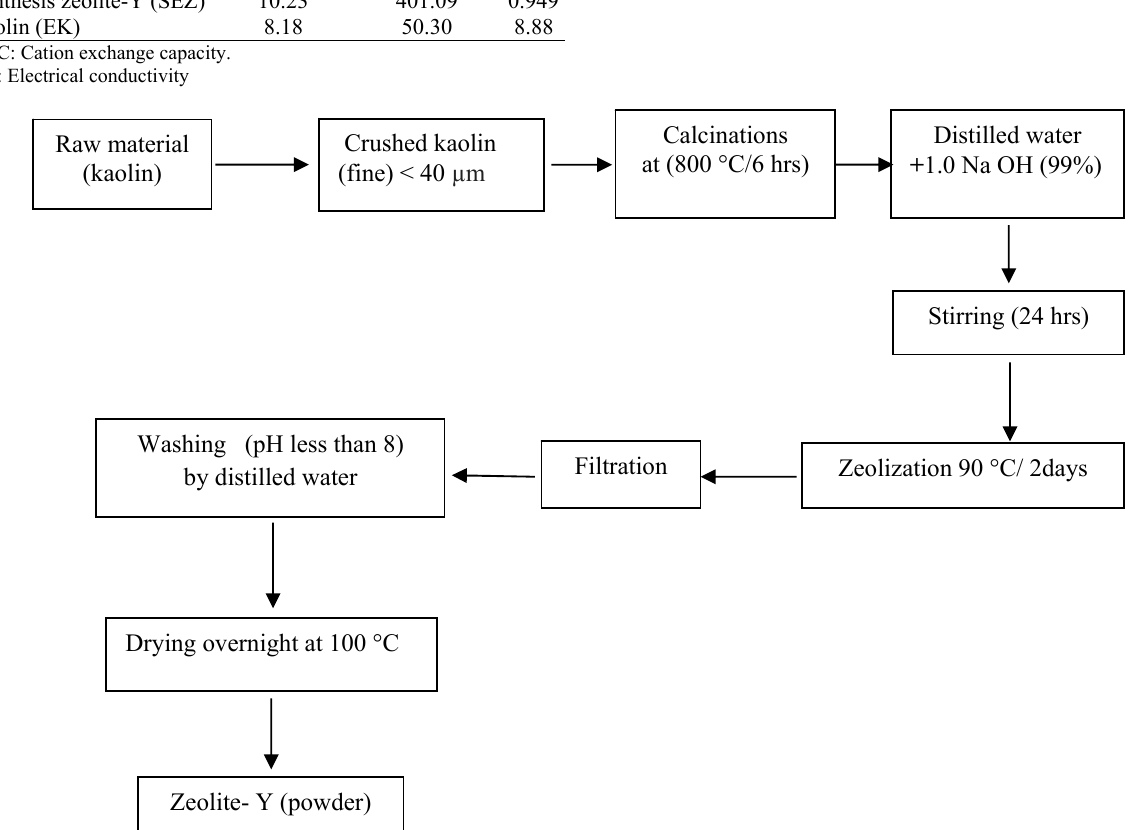
Fig. 2. Schematic diagram for the preparation of zeolite-Y from